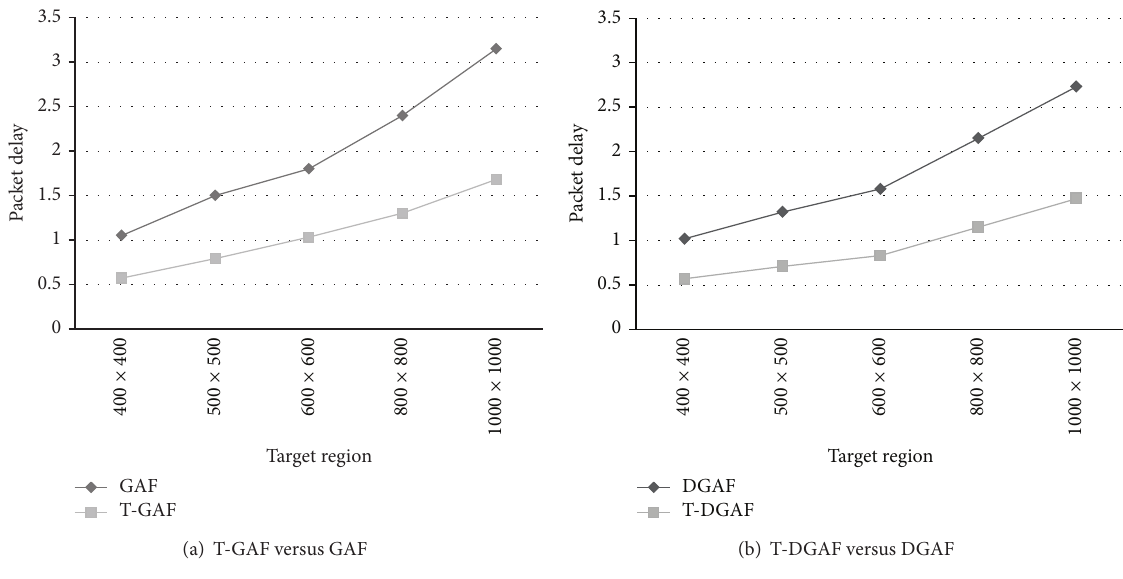
Figure 11: Comparison of the average packet delay for different size of target